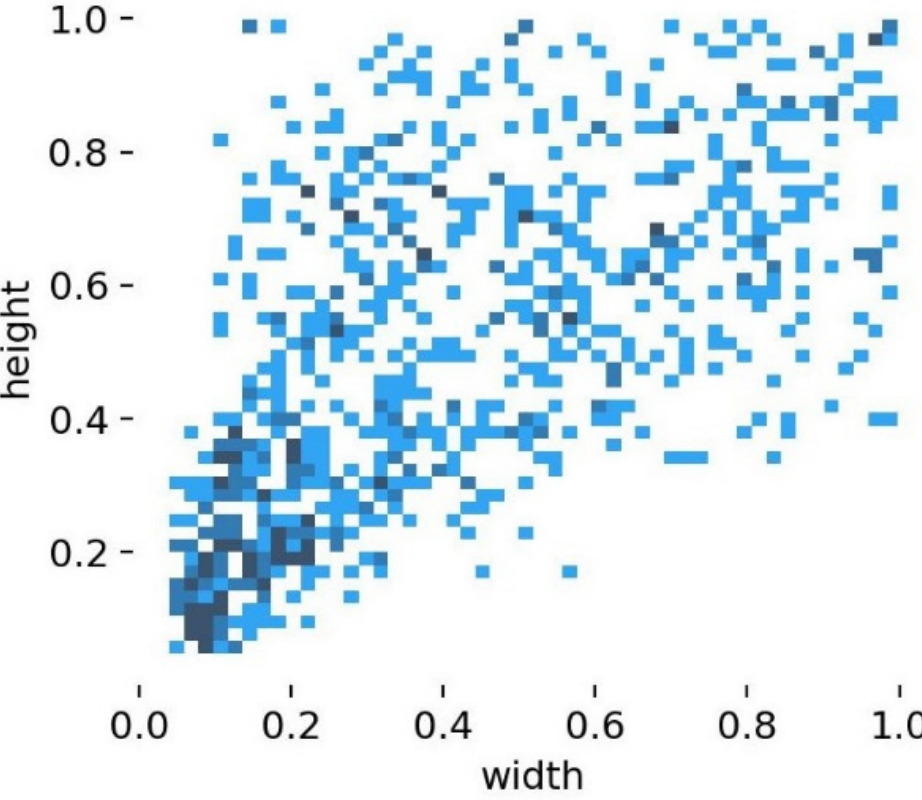
Figure 7. Target width and height distribution map.